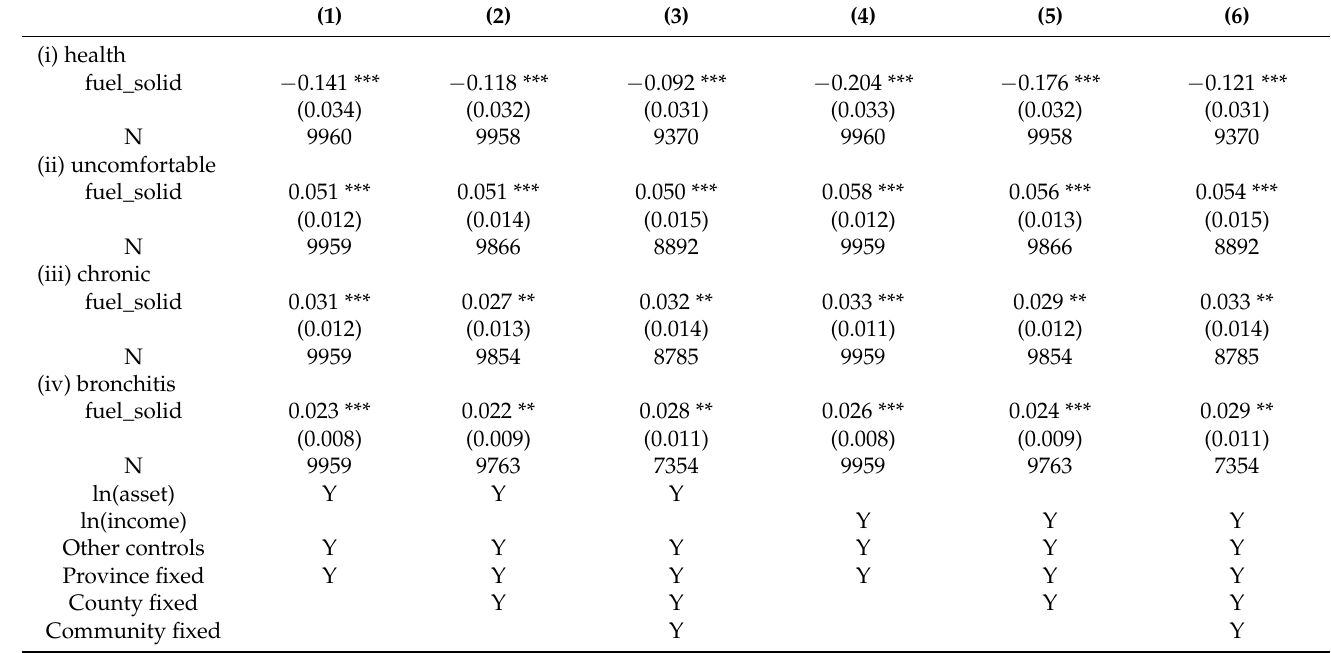
Table 5. Effects of solid cooking fuels on health